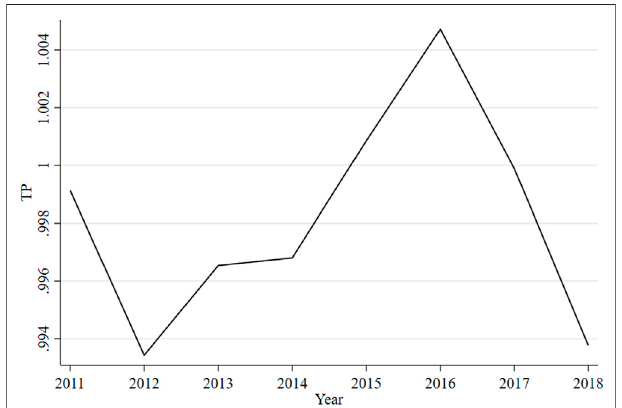
FIGURE 1 | The trend of average provincial technological progress in 2011 – 2018.